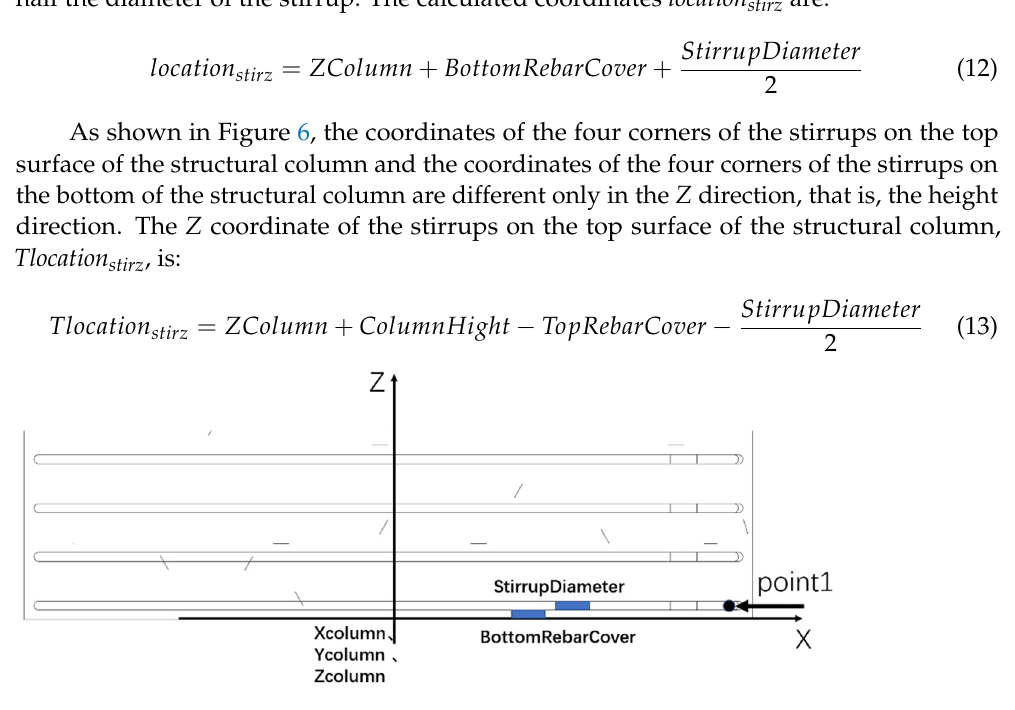
Figure 6. Schematic diagram of the stirrup height coordinate calculations. ColumnHight is the height of the current structural column.